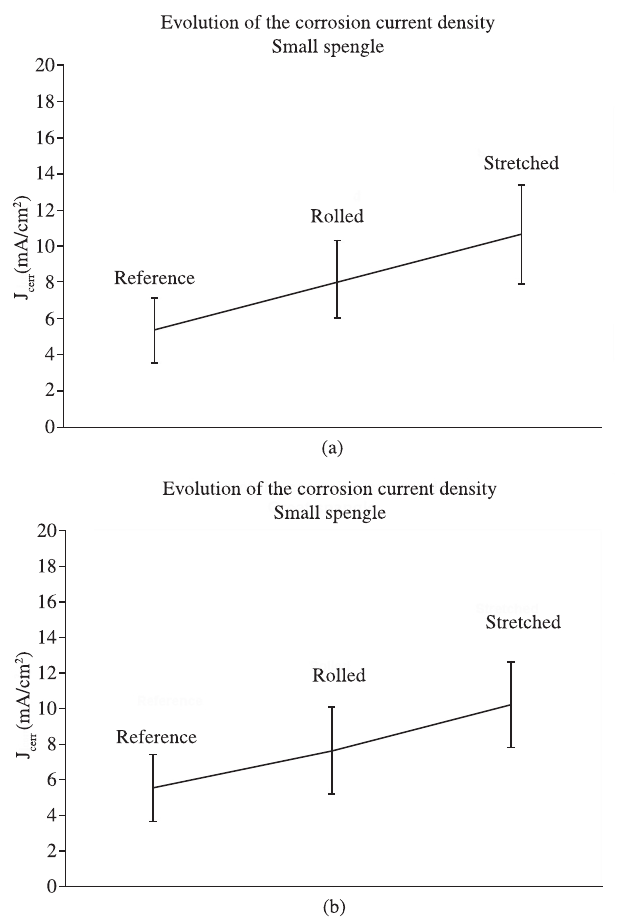
Figure 8. Corrosion current density dependence on the deformation type. a) Small spangle and b) Great